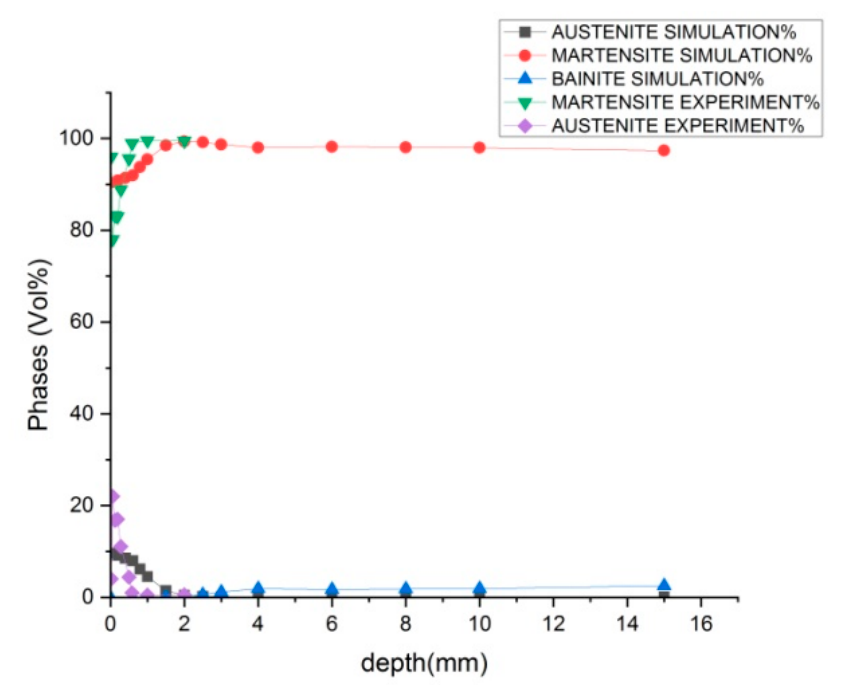
Figure 19. The content of the microstructure from XRD.